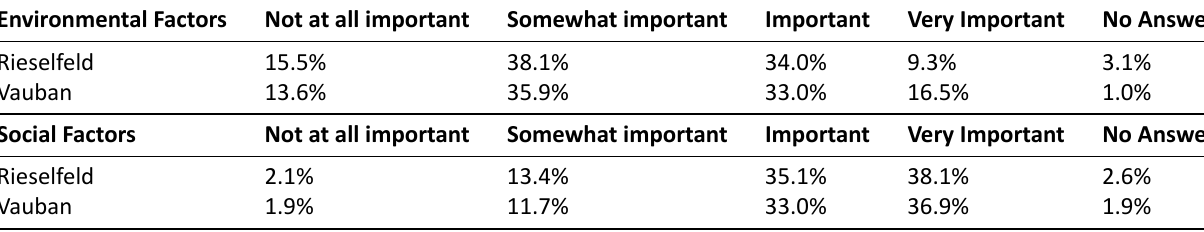
Table 4. Importance of environmental and social factors for moving to Rieselfeld/Vauban. Environmental